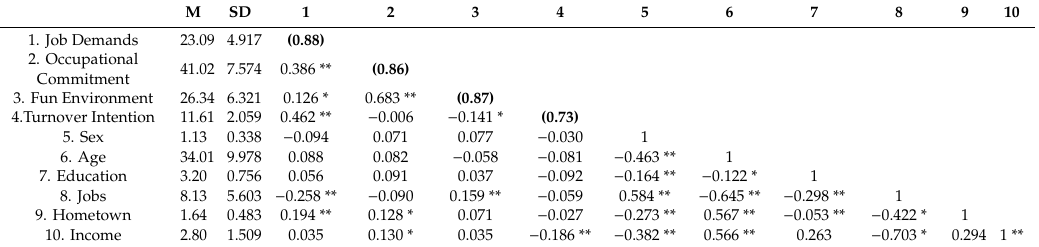
Table 3. Results of Descriptive and Correlation Analysis.